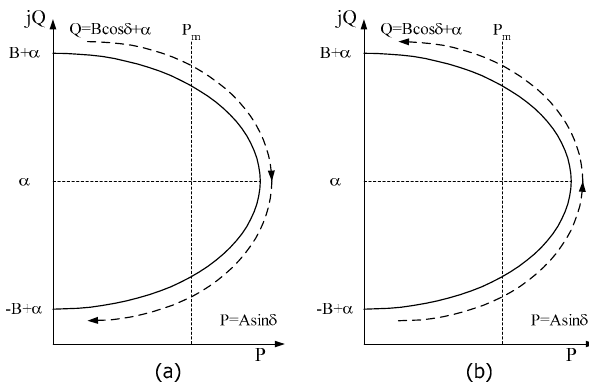
Figure 7. The trajectory of the complex power according to the line parameters. ( a ) B is positive, ( b ) B is negative.